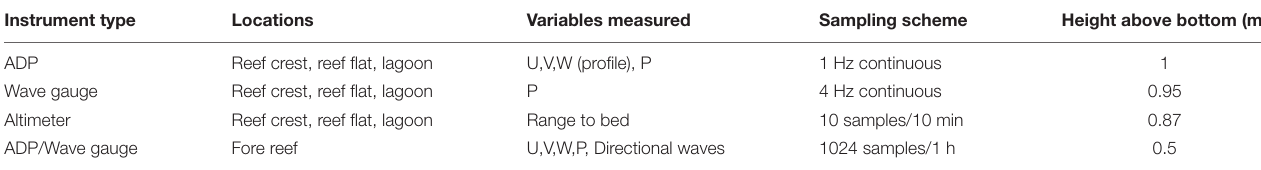
TABLE 1 | Instrumentation used in the